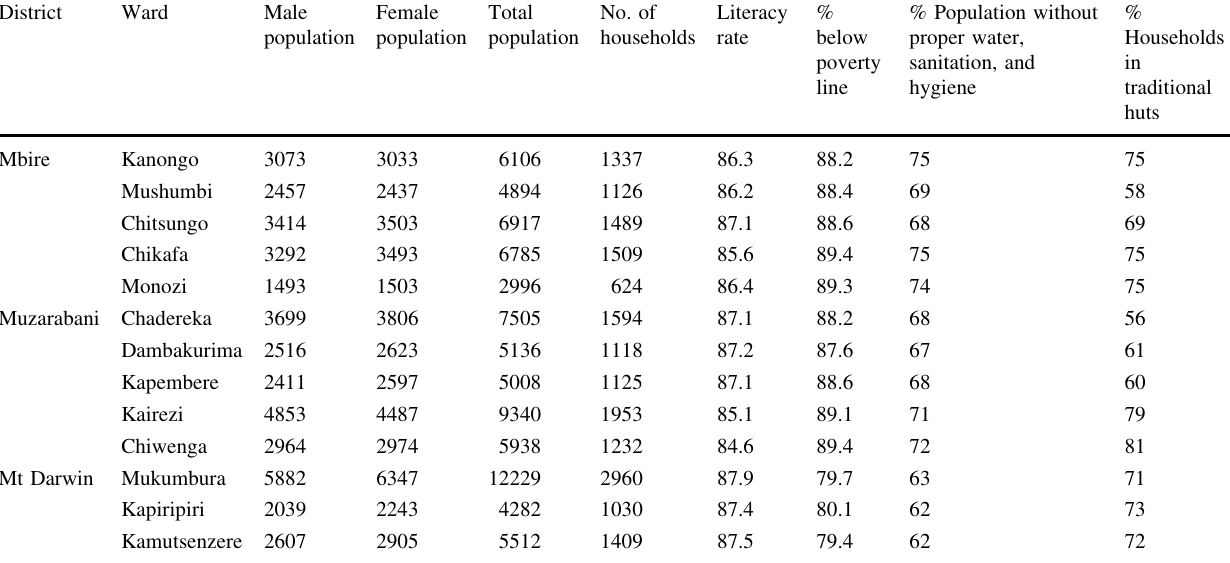
Table 1 Basic demographic statistics of case study wards in Mbire, Muzabarani, and Mt Darwin districts in Mashonaland Central Province of northern Zimbabwe. Source ZimStat (2012), UNDP (2016)